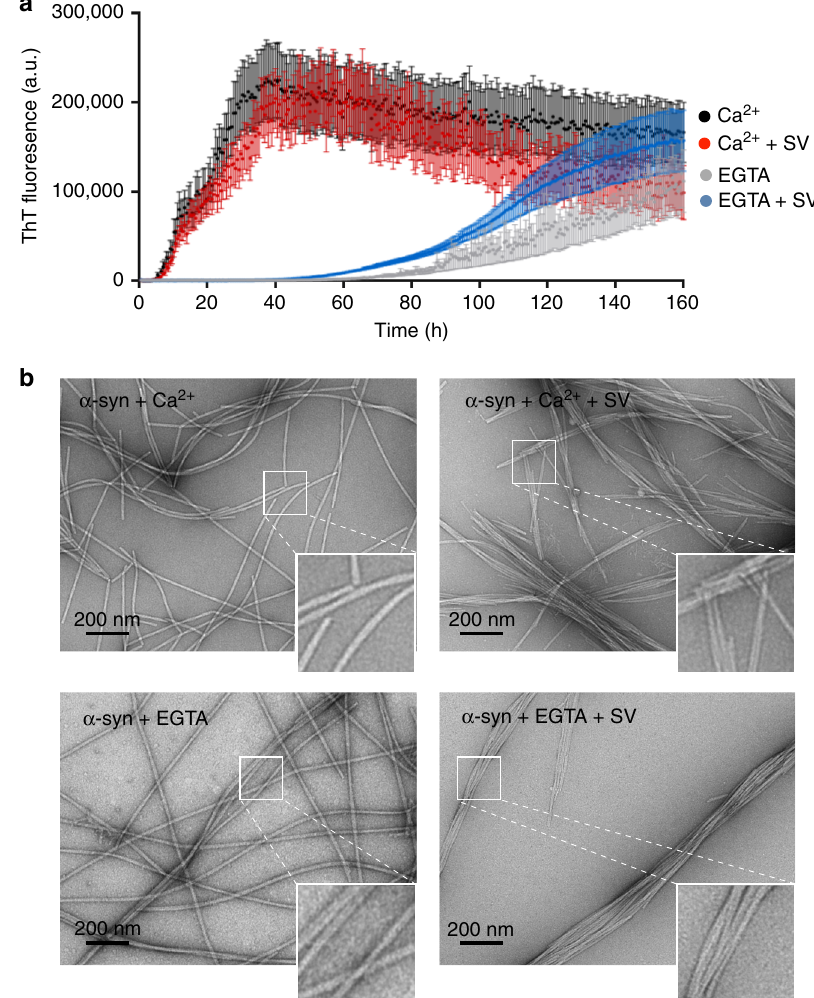
Fig. 5 The effect of calcium and synaptic vesicles on alpha-synuclein aggregation. a Alpha-synuclein aggregation measured by ThT fl uorescence using 100 µ M monomeric alpha-synuclein under shaking conditions. The presence of 2.5 mM calcium increased the aggregation kinetics of alpha-synuclein compared to 1 mM EGTA, both in the presence or absence of synaptic vesicles (black and red). For the EGTA-containing groups, there was a trend towards faster aggregation of alpha-synuclein in the presence of synaptic vesicles (blue vs. gray). Three biological repeats, n = 18 for all conditions, where n represents single wells. values represent mean ± s.e.m. b TEM images of alpha-synuclein fi brils formed in the presence of 2.5 mM calcium or 1 mM EGTA either in the presence or absence of synaptic vesicles. Differences in the morphology of alpha-synuclein fi brils were observed for fi brils formed in the presence of 2.5 mM calcium in the absence and presence of synaptic vesicles. In the presence of synaptic vesicles, alpha-synuclein fi brils showed increased lateral bundling and shortening. Alpha-synuclein aggregation in the presence of 1 mM EGTA led to substantially less fi brils, however the fi brils formed, retained their morphological phenotype compared to the fi brils formed in the presence of 2.5 mM calcium. Alpha-synuclein fi brils formed in the presence of synaptic vesicles plus 1 mM EGTA showed an intermediate phenotype, with bundled, but more elongated fi bril structures than found in the synaptic vesicles and 2.5 mM calcium group. Experiments were repeated synuclein (Fig. 4d; Supplementary Fig. 8), indicating that high levels of calcium and/or alpha-synuclein are key elements of neuronal toxicity.